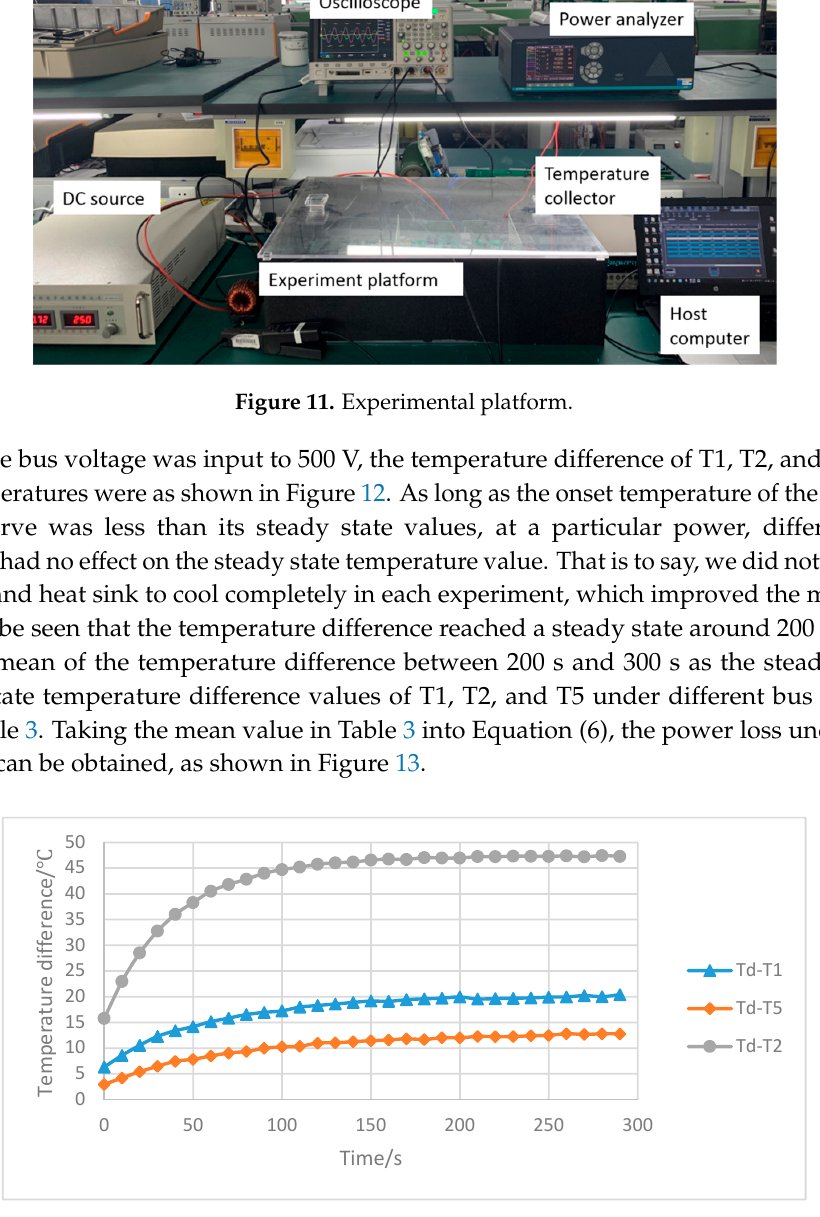
Figure 12. Temperature difference of T1, T2, and T5 when bus voltage is 500 V.